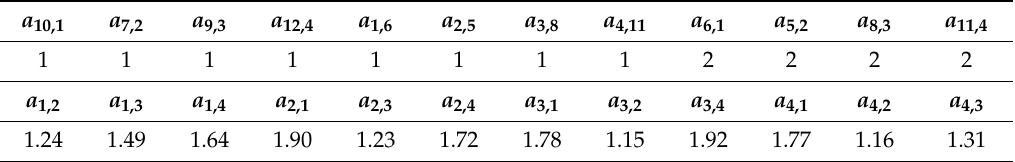
Table 2. The connection weight of neuronal axons in the